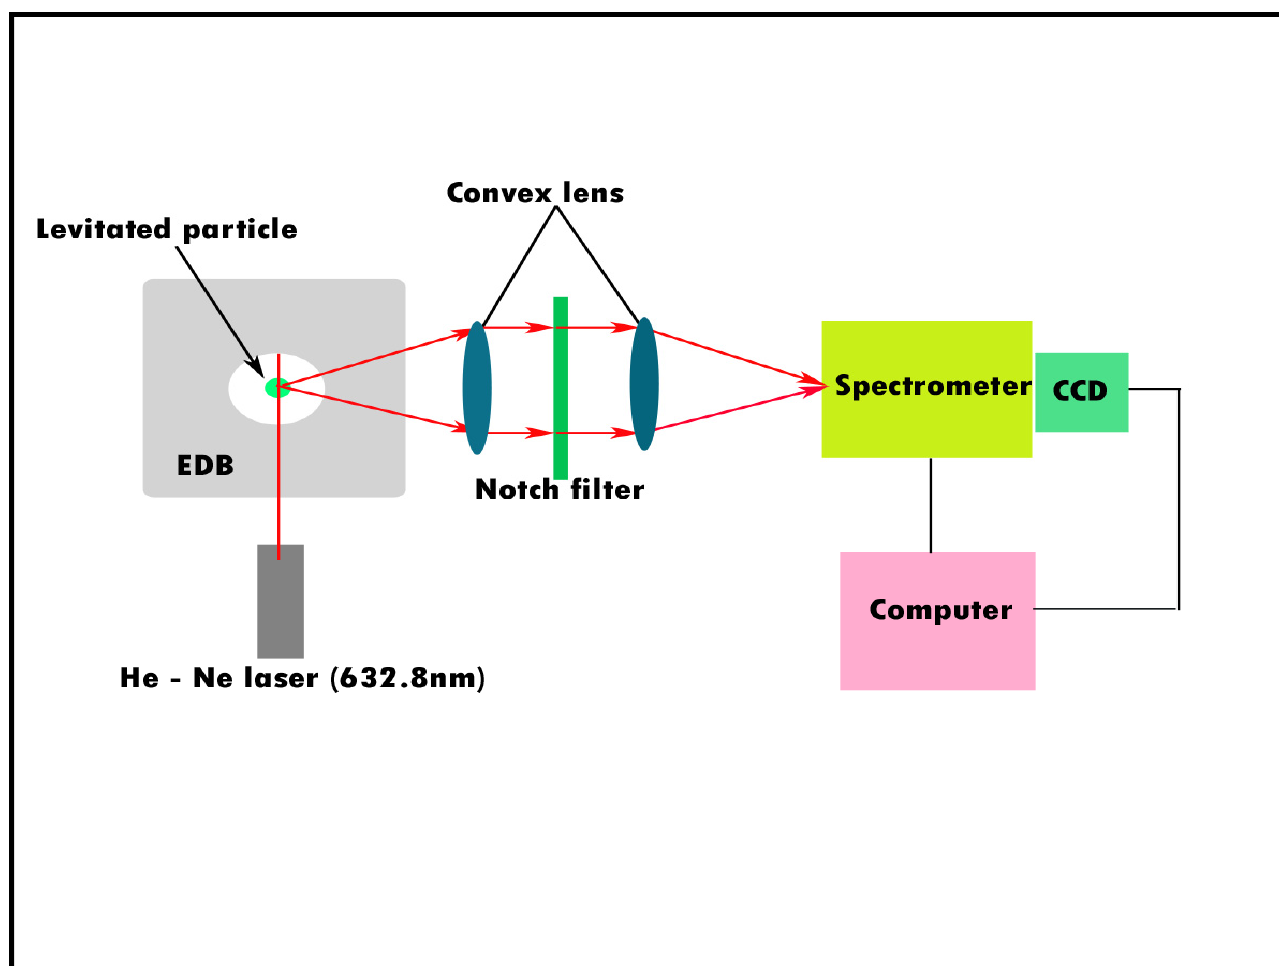
Figure 2. Schematic representation of electrodynamic balance (EDB) – Raman system.